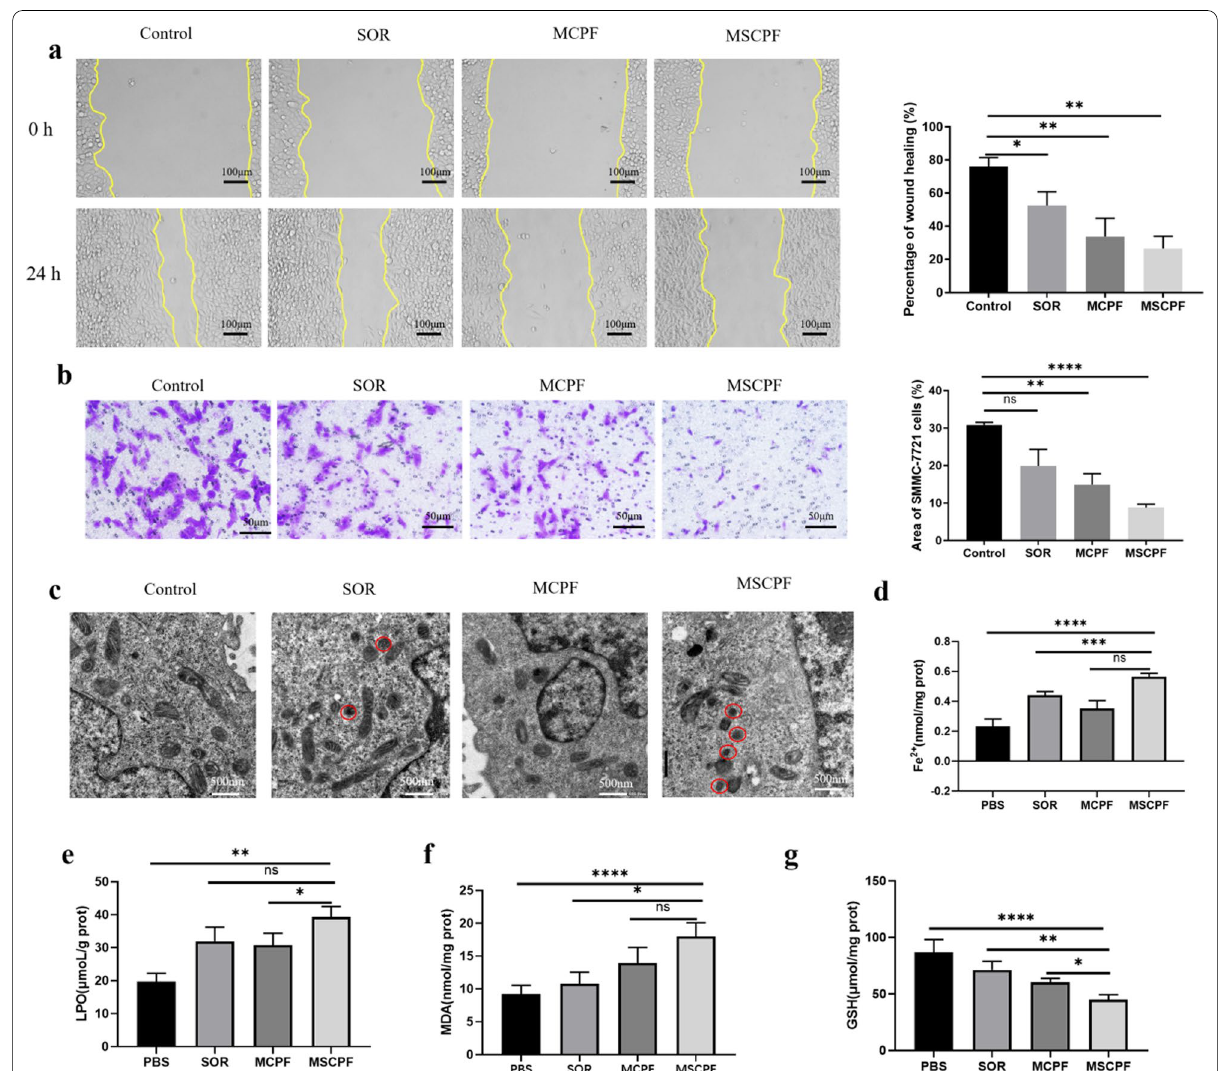
Fig. 5 a Cell migration detected by wound healing assay. The statistical graph (right) shows the corresponding cell migration rate. b Images of cell invasion by transwell assay. (c) TEM observations of the mitochondria morphology of SOR, MCPF, and MSCPF corresponding to the in vitro studies. d–g Intracellular content of free Fe 2 + , lipid peroxidation (LPO), malondialdehyde (MDA), and glutathione (GSH) in SMMC-7721 cells treated by SOR, MCPF, and MSCPF (660 nm irradiation at 500 mW cm − 2 and 808 nm irradiation at 1.5 W cm − 2